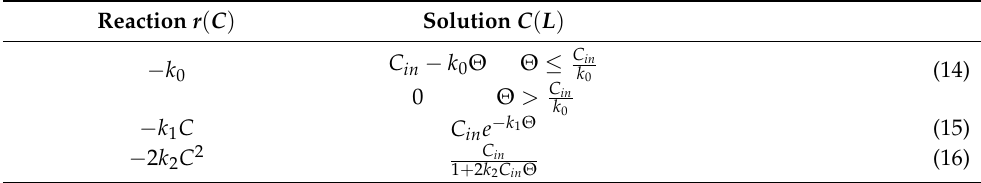
Table 2. Solutions for the outlet concentration C ( L ) in the PFR for the different reaction orders.